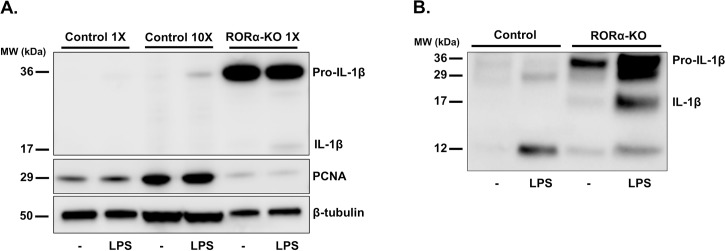
RORA knockout cells produce IL-1β.A. Western blot analysis of total cell lysates of RORA-deletion cells reveals accumulation of pro-IL-1β even in the absence of LPS stimulation. Pro-IL-1β was not detectable in LPS-stimulated lysates from the equivalent number of control cells and was detectable only in 10-fold excess of lysates. PCNA and beta Tubulin were used as loading controls. B. Western blot of supernatants after 24 hours incubation with or without 10 ng/ml LPS. RORA-deletion strains accumulate substantial amounts of pro-IL-1β in the supernatants even in the absence of LPS stimulation. Addition of LPS stimulated secretion of some mature IL-1β from RORA-KO cells.